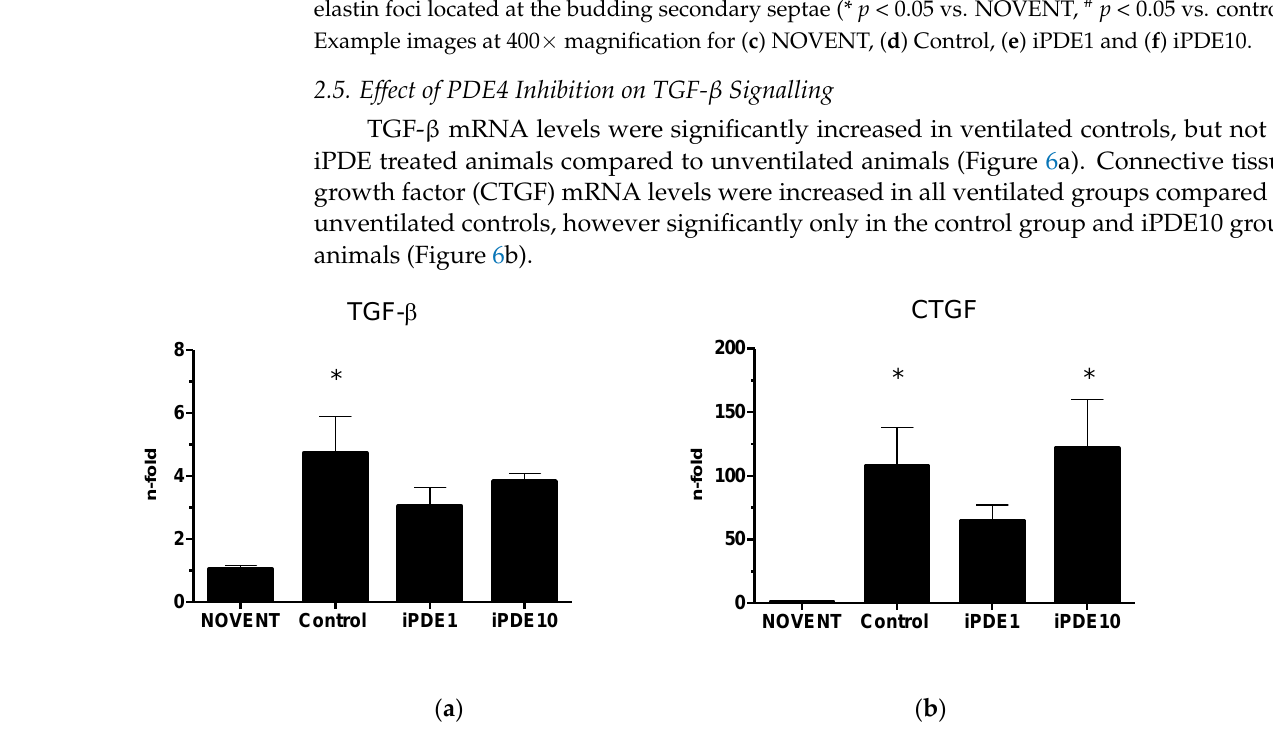
Figure 6. ( a ) TGF- β and ( b ) CTGF mRNA levels relative to unventilated controls (mean ± SEM, * p < 0.05 vs. NOVENT).